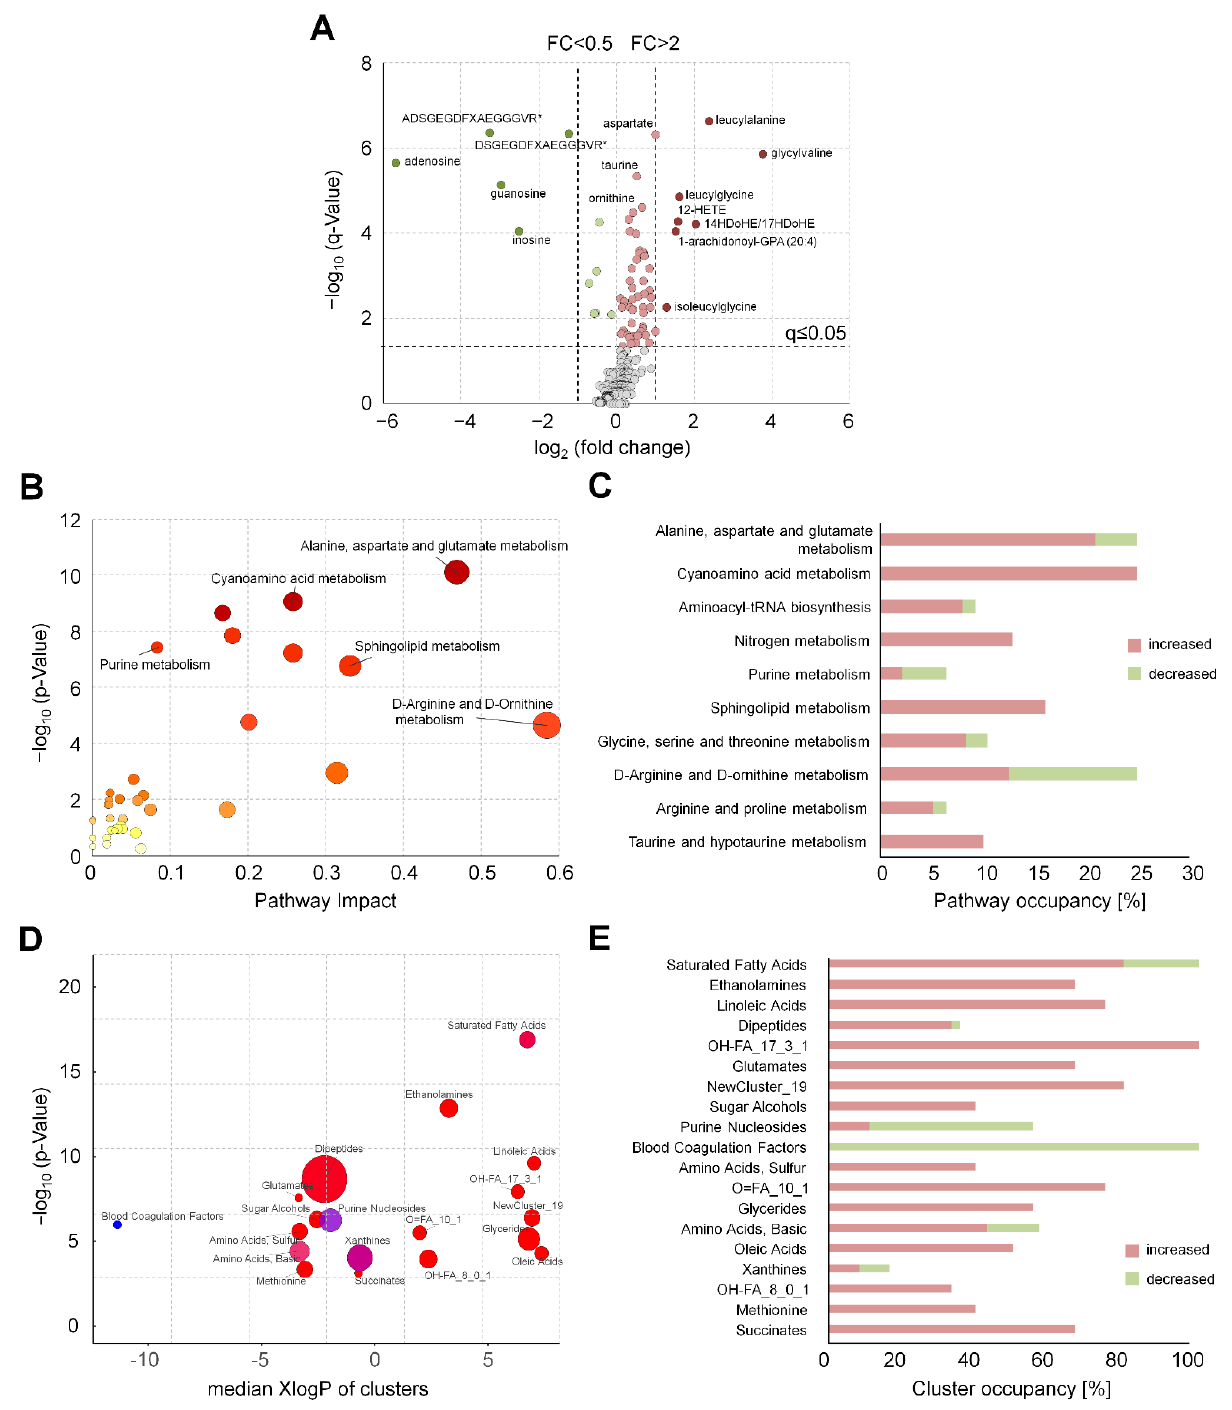
Figure 1. Chemical similarity and pathway enrichment analysis to identify novel QIs for the precentrifugation delay in human serum. ( A ) Volcano plot of serum metabolites visualizes the effects of prolonged blood incubation after 2 h before centrifugation. Red (increase) and green (decrease) circles indicate altered metabolite levels ( discovery sample , n = 10). A paired t -test was performed, and we applied addressed multiple testing by deriving q-values to control the positive false discovery rate. ( B ) Represents the pathway enrichment analysis using the altered metabolites of ( A ). Node size represents the impact of the altered metabolites on the pathways and node color visualizes the q-value. ( D ) ChemRICH set enrich- ment statistics plot. Each node reflects an altered cluster of metabolites ( p -value ≤ 0.05). Node sizes represent the total